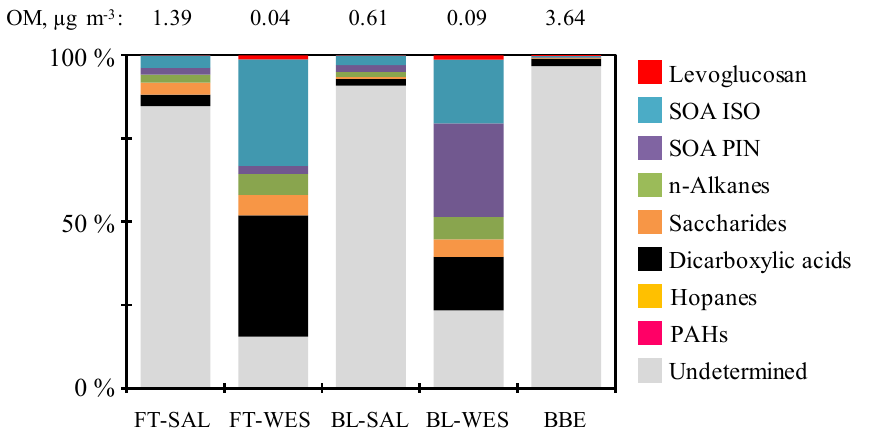
Figure 4. Contribution of the eight analysed organic groups to the Izaña OM composition within the FT and the BL under the SAL (FT-SAL and BL-SAL) and the WES (FT-WES, BL-WES, BBE). Average total OM for each air mass is at the top. FT-PM T samples were collected during the night (22:00–06:00GMT) and BL-PM 2 . 5 samples were collected during the day (10:00–16:00GMT).